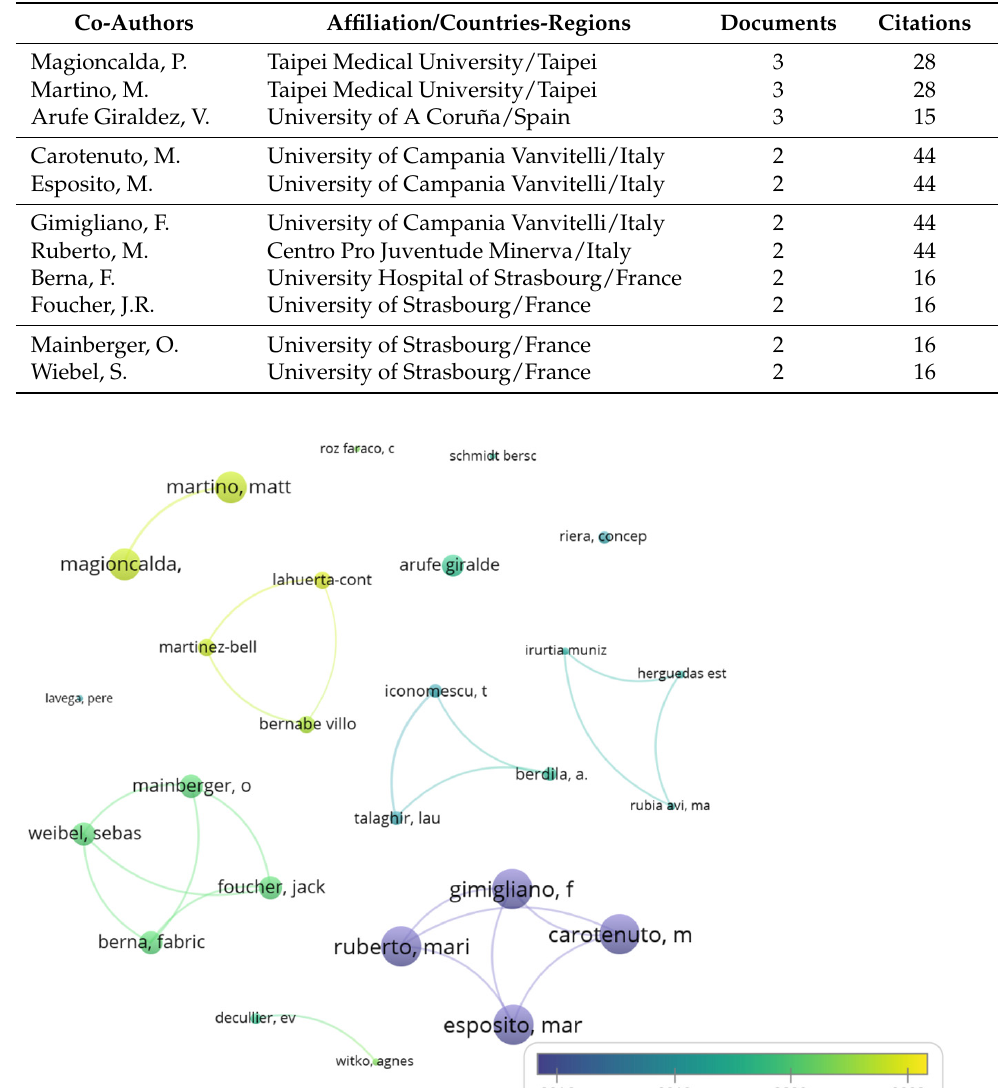
Table 1. Most prominent co-authors in psychomotricity.